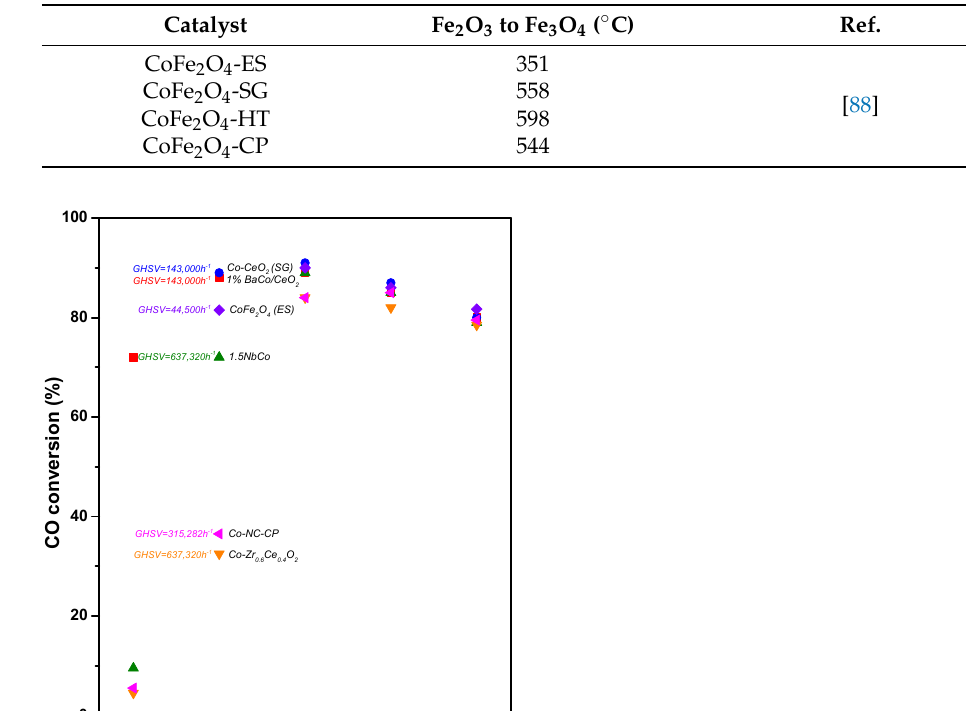
Table 10. Reduction characteristics of CoFe 2 O 4 catalysts.